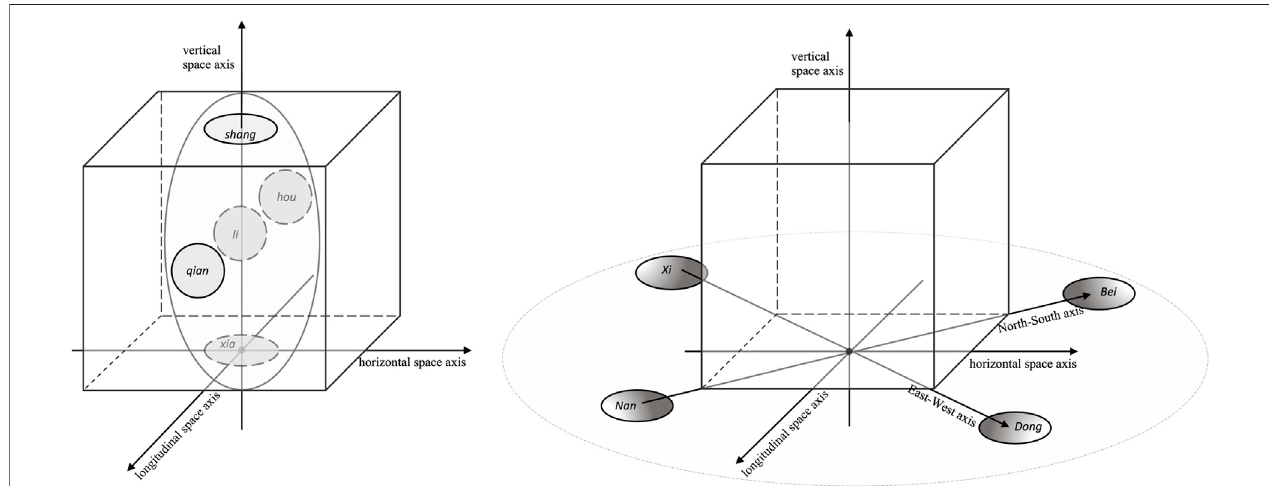
FIGURE 2 | The semantic map for zai : partitioning according to semantic types. The map on the left represents the fi ve locations that licensed the highest acceptancerates,labelled via thecorrespondinglocalisers(i.e., qian “ front ” , hou “ behind ” , shang “ up ” , xia “ down ” ,and li “ in ” ).Astheshadecodesuggests,mostthough not all participants accepted that zai could accept zai as directly referring to these locations. As a result, the partial halo including these locations also represents the hyponymy relations between these prepositions and the corresponding localisers and therefore has a non-cylindrical shape. The map on the right instead representsthefour cardinallocationsthatlicensed thelowest acceptancerates(localisers are bei “ north ” , xi “ west ” , dong “ east ” ,and nan “ south ” ).Thedarker shadesof grey and the dimmer contour for the halo represent this fact, and also the fact that the acceptance of the corresponding hyponym relation also involved lower rates.